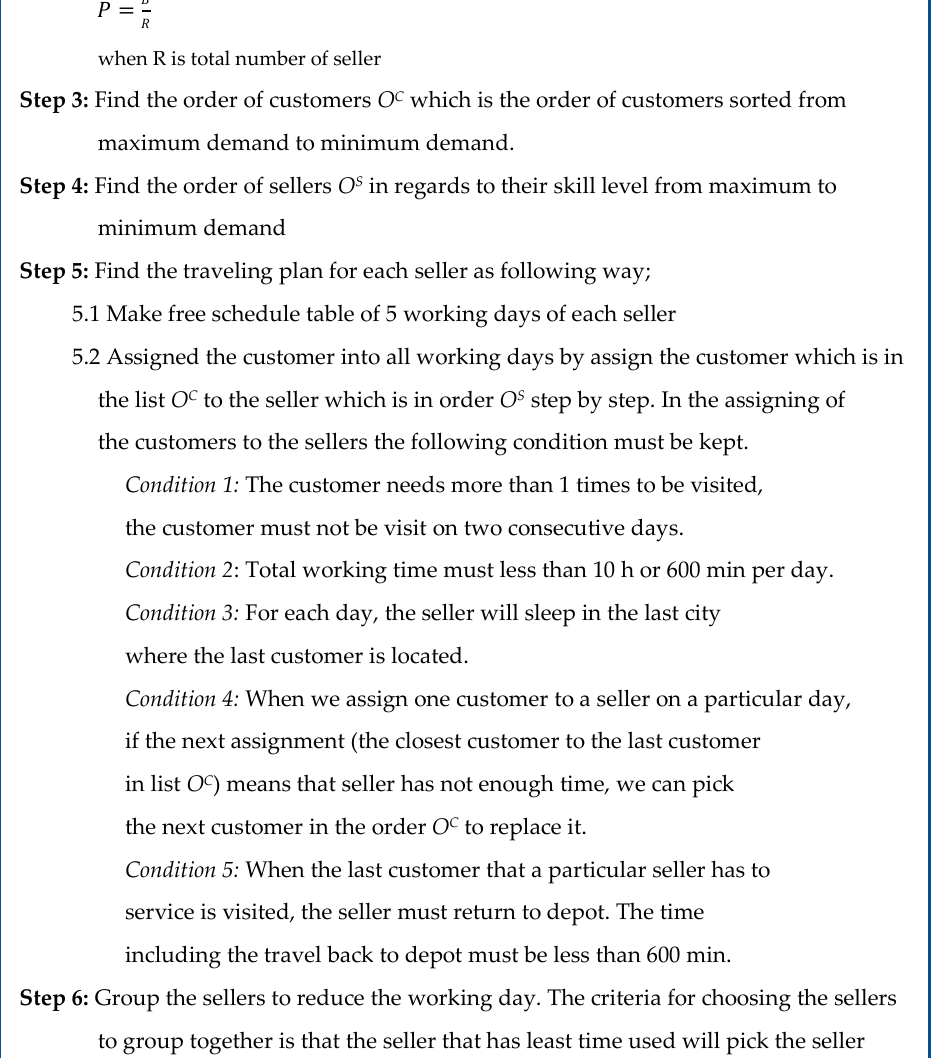
Figure 6. CPP procedure.